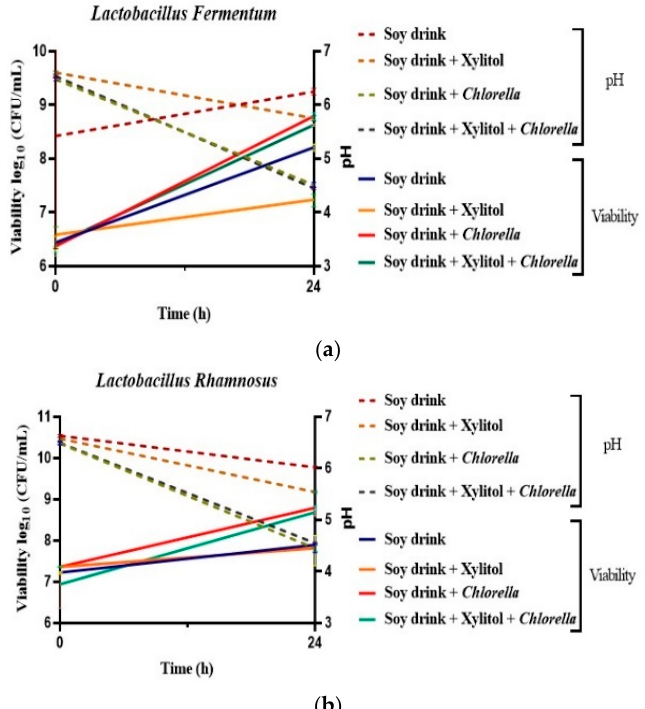
Figure 2. Cell viability and pH profile of the fermentation with ( a ) L. fermentum and ( b ) L. rhamnosus . Values for LAB viable cell growth and pH are displayed as mean values, log10 CFU/mL, n = 3, GraphPad Prism Version 8.0.1; soy drink (1); soy drink + xylitol (1.5%); soy drink + C. vulgaris (1.5%), soy drink + xylitol+ C. vulgaris (1.5%); CFU/mL (colony-forming units/milliliter of the sample).